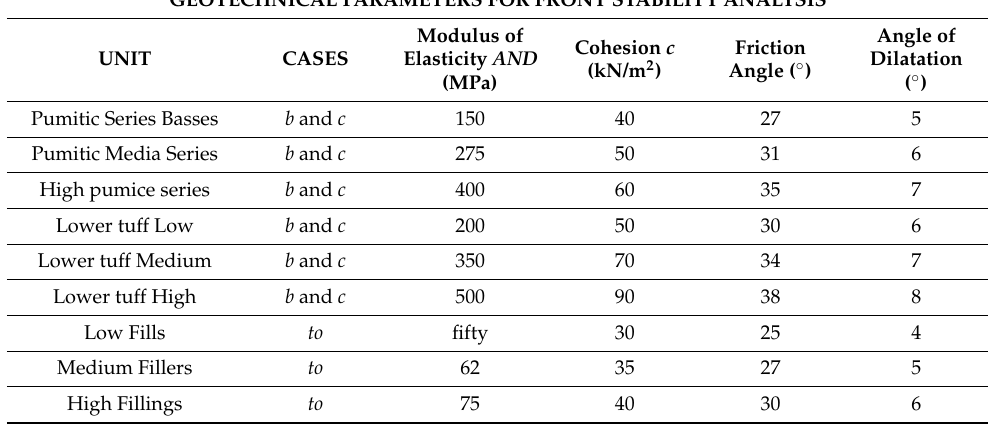
Table 4. Basic parameters for the front stability analysis.